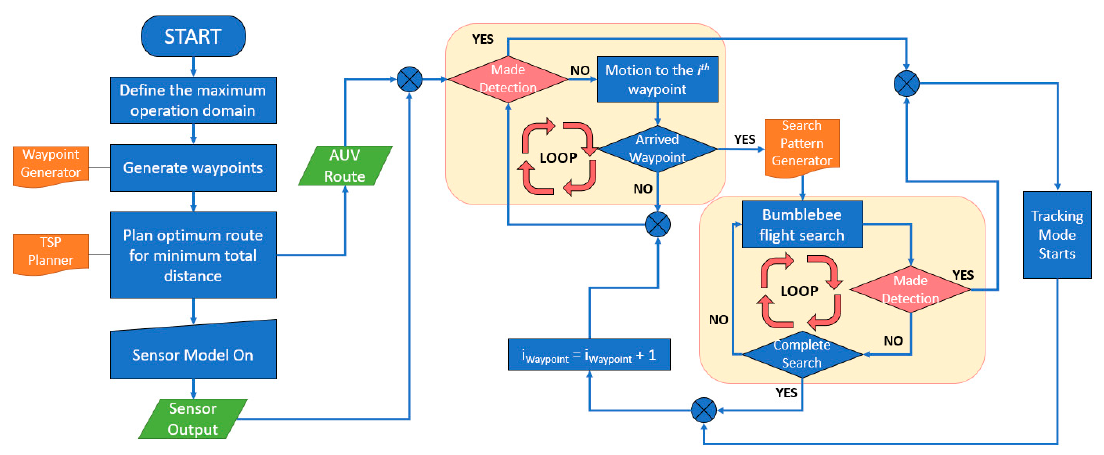
Figure 1. Flowchart describing the designed adaptive sampling procedure. Four independent iteration modes are highlighted in the yellow boxes.